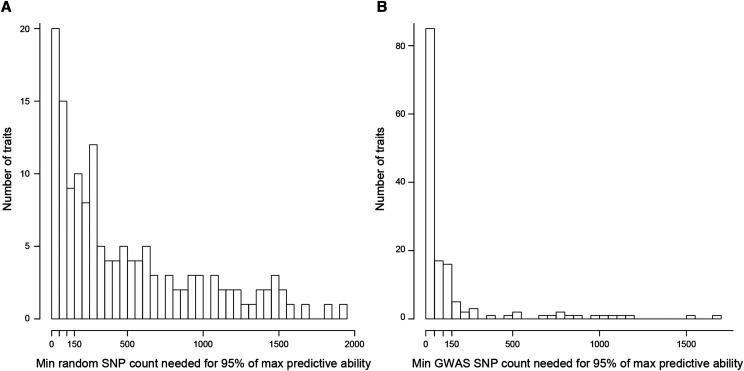
Histogram of the number of traits for which the minimum number of SNPs required to reach 95% of the maximum predictive ability of the best genomic prediction (using any number of SNPs) falls within the shown range. To reach the 95% threshold, the SNPs were either (a) randomly chosen or (b) chosen from the most to the least significant one among a non-redundant set detected in a preliminary GWAS using the calibration set of populations. The calibration set of all minus 50 populations was selected by optimizing genetic distances and the 50 populations left were used to test the models.